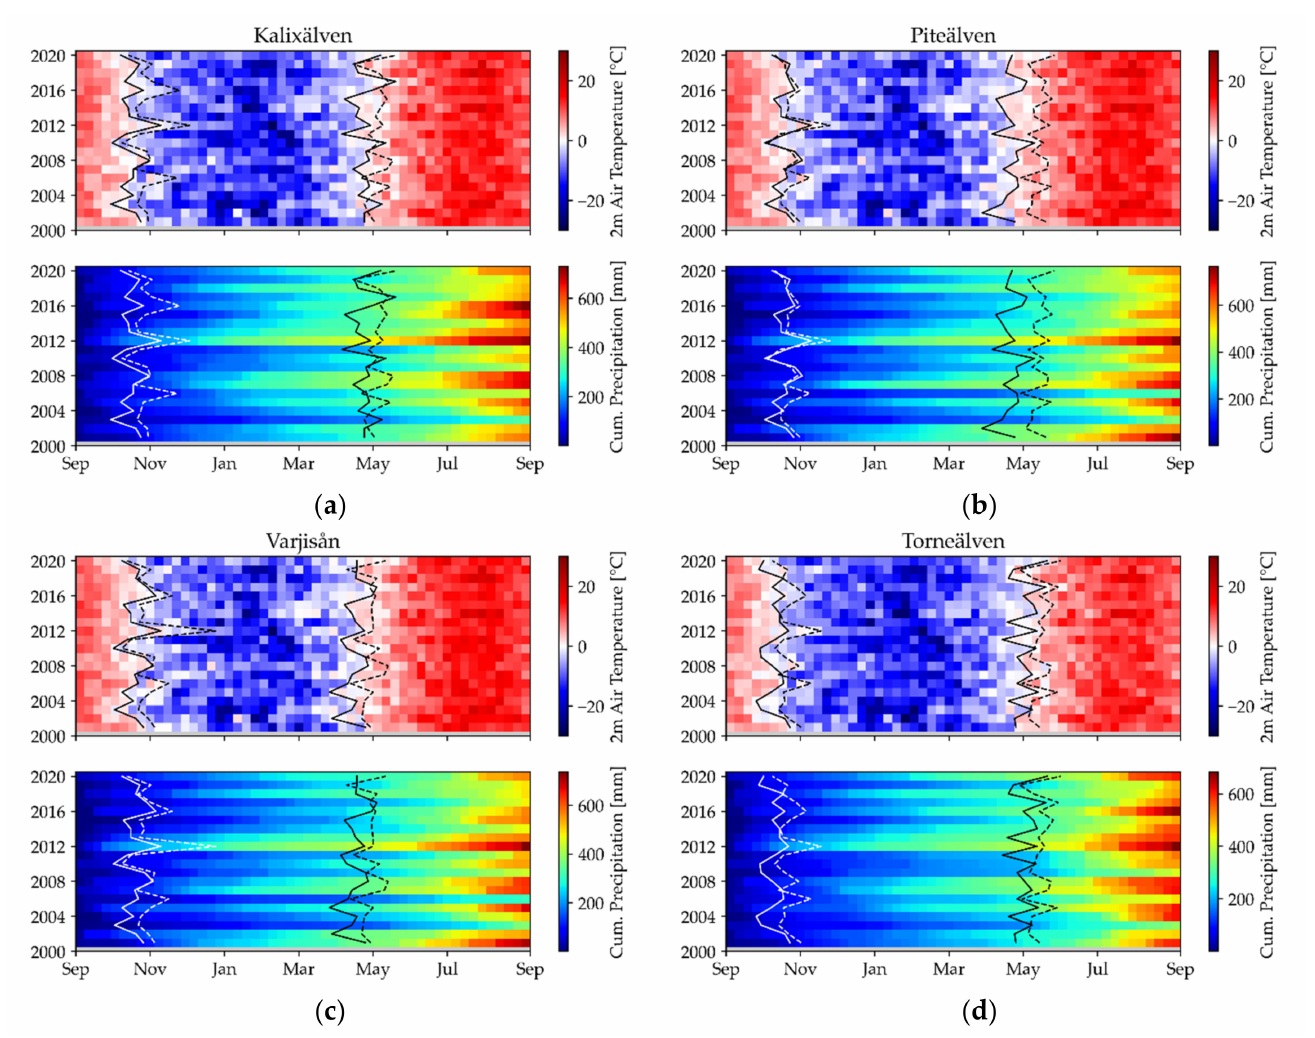
Figure 10. Weekly mean air temperature and weekly sum of precipitation for ( a ) Kalixälven, ( b ) Torneälven, ( c ) Vindelälven, and ( d ) Kemihaara. The earlier lines show the snow cover start, the later the beginning of snowmelt. Solid lines are derived from the satellite product; dashed are derived from the air